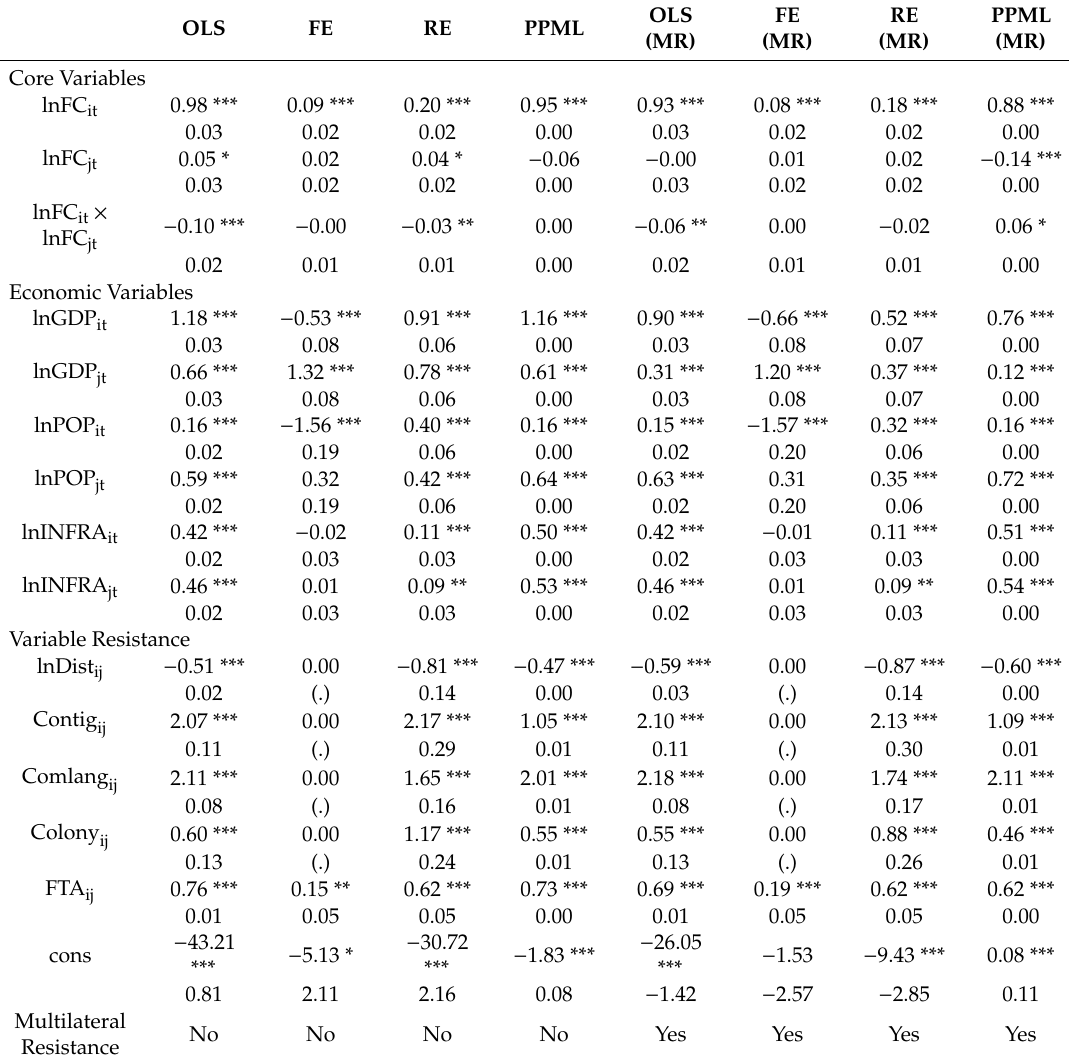
Table 6. The regression results of the total